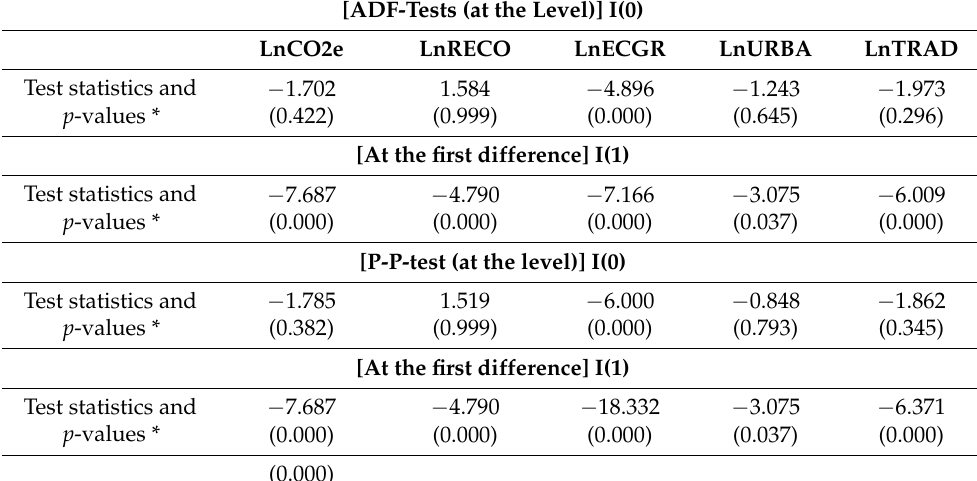
Table 5. Unit root tests results.